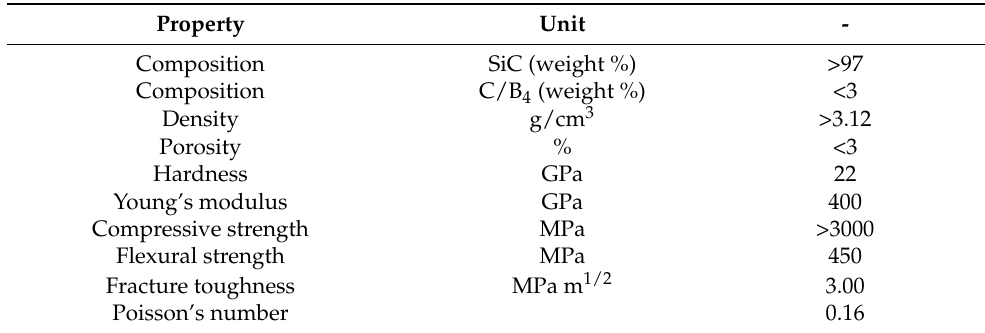
Table 1. The composition and properties of the used sintered